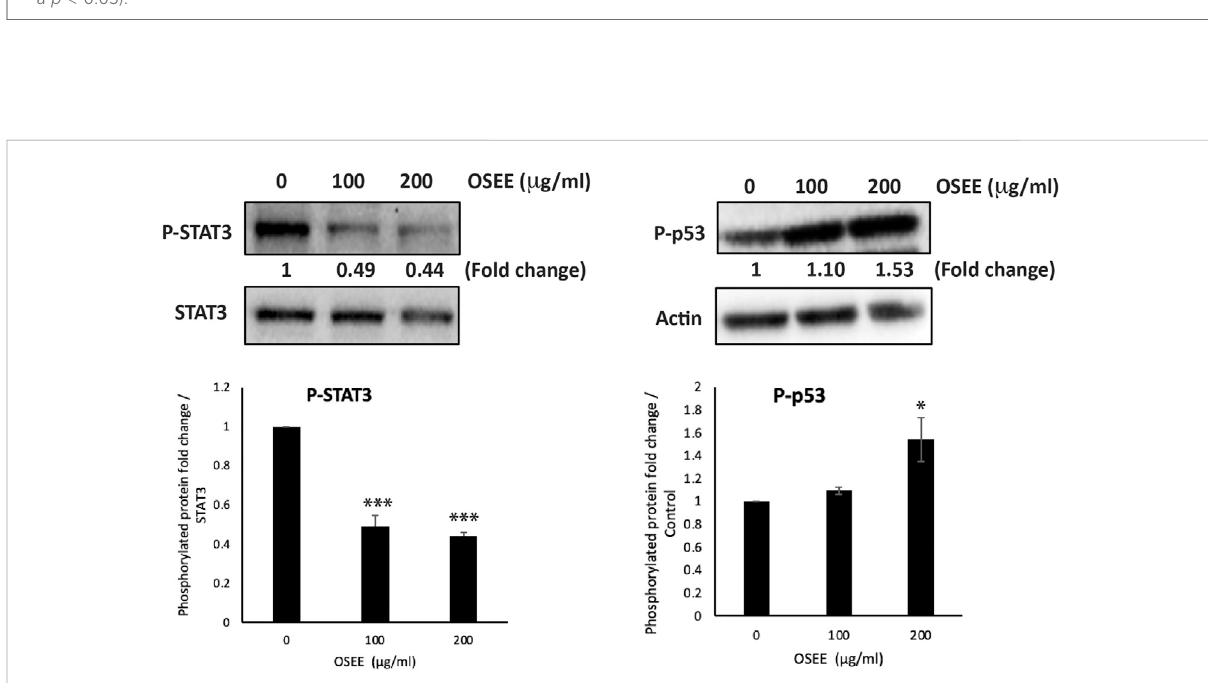
FIGURE 6 O. syriacum inhibits the STAT3 signaling pathway in MDA-MB-231 cells. MDA-MB-231 cells were treated with and without the indicated concentrations of OSEE for 24 h and protein lysates were examined for the phosphorylation of STAT3 and levels of phospho-p53 by Western blotting. Values represent the mean ± SEM of three independent experiments ( n = 3). * p < 0.05 and *** p < 0.001.